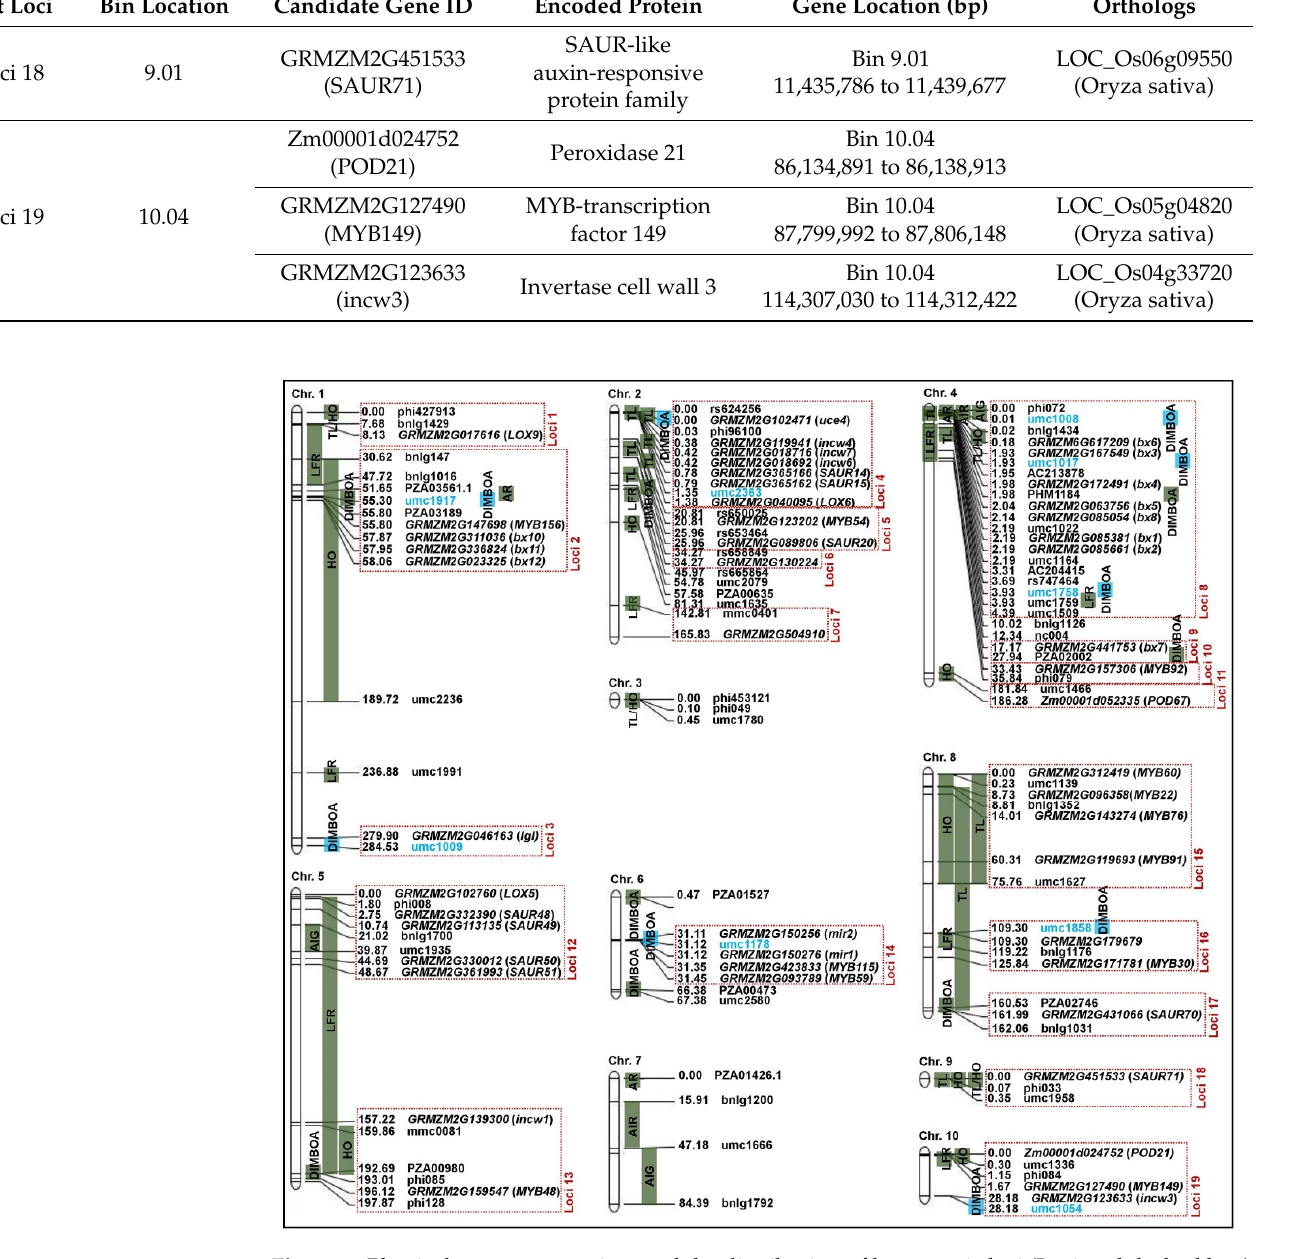
Figure 5. Physical map construction, and the distribution of hot genetic loci (Loci, red dashed box), candidate genes, and original genetic loci for multiple insect-resistant traits including tunnel length of corn borer (TL), aphid incidence rate (AIR), average aphid incidence grade (AIG), aphid resistance (AR), DIMBOA content, leaf feeding rating of corn borer (LFR), number of holes of corn borer (HO), and tunnel length/number of holes of corn borer (TL/HO) in the physical map. The light green rectangles represent original genetic loci from previous studies. The blue rectangles represent our results. The blue markers represent the associated markers in our results.